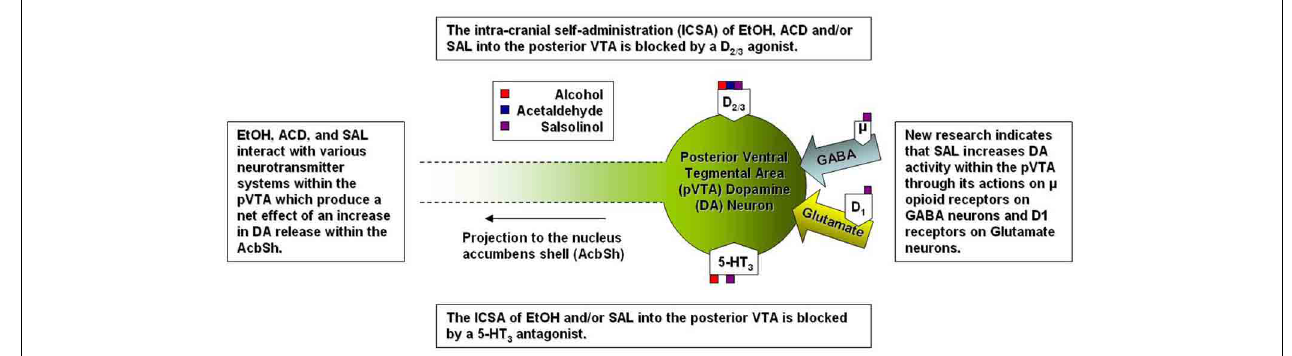
FIGURE 2 | A simplified representation of the sites of action for alcohol and alcohol metabolites on posterior ventral tegmental area dopamine